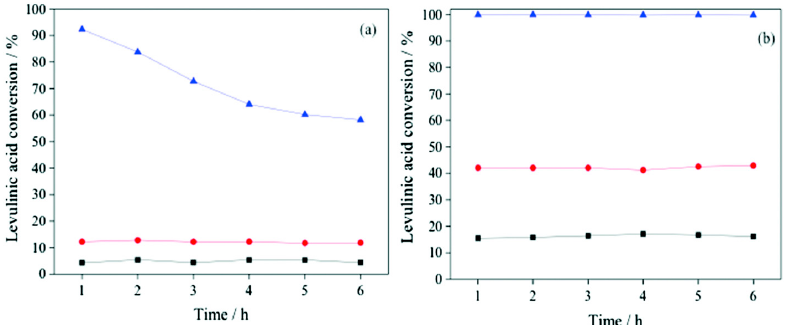
Figure 7. Levulinic acid conversion versus time over Mo 2 C/AC ( a ) and Mo 2 C/CNT ( b ) at 30 bar of H 2